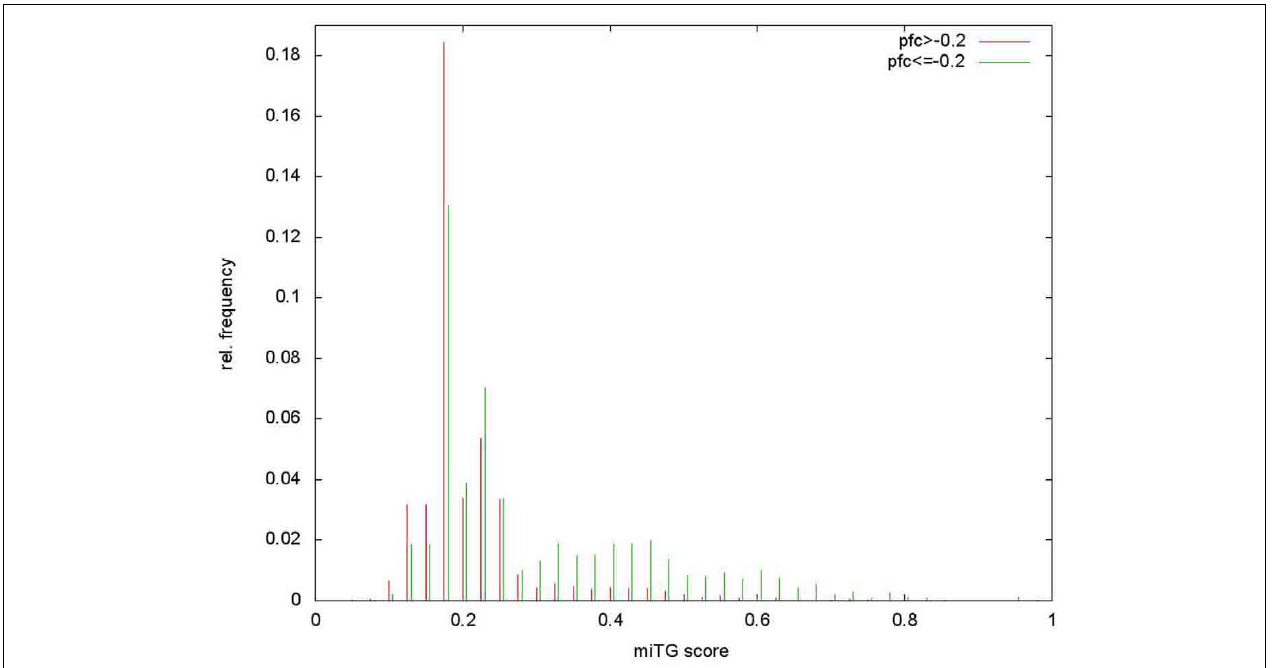
FIGUREA1 | Determination of loose score threshold cutoff. The loose threshold is obtained from the score distribution of targeted and non-targeted genes on the Selbach et al. (2008) data that shows a bimodal shape that can be separated at a cutoff of 0.33. Score distributions on positive and negative data.